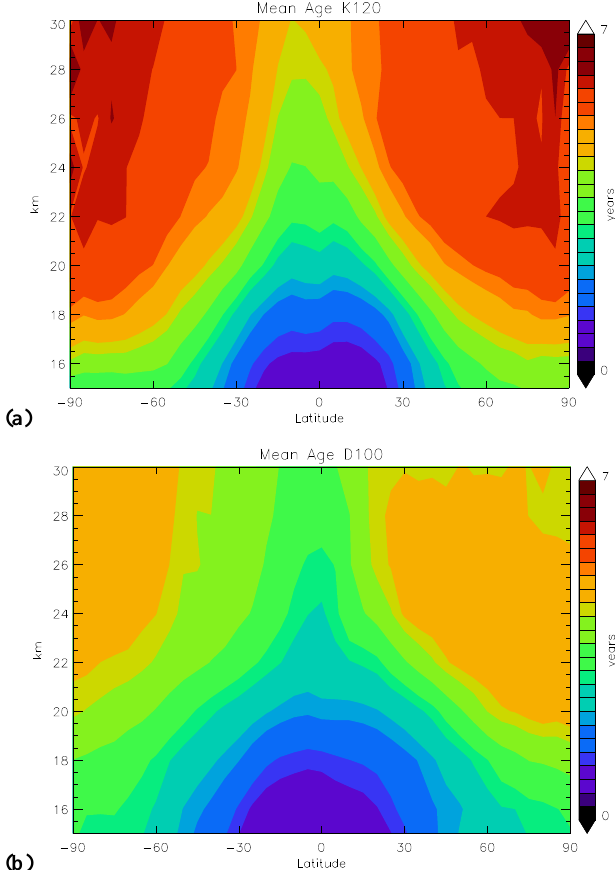
Fig. 3. (a) mean age for a kinematic trajectory run. (b) mean age for a diabatic trajectory